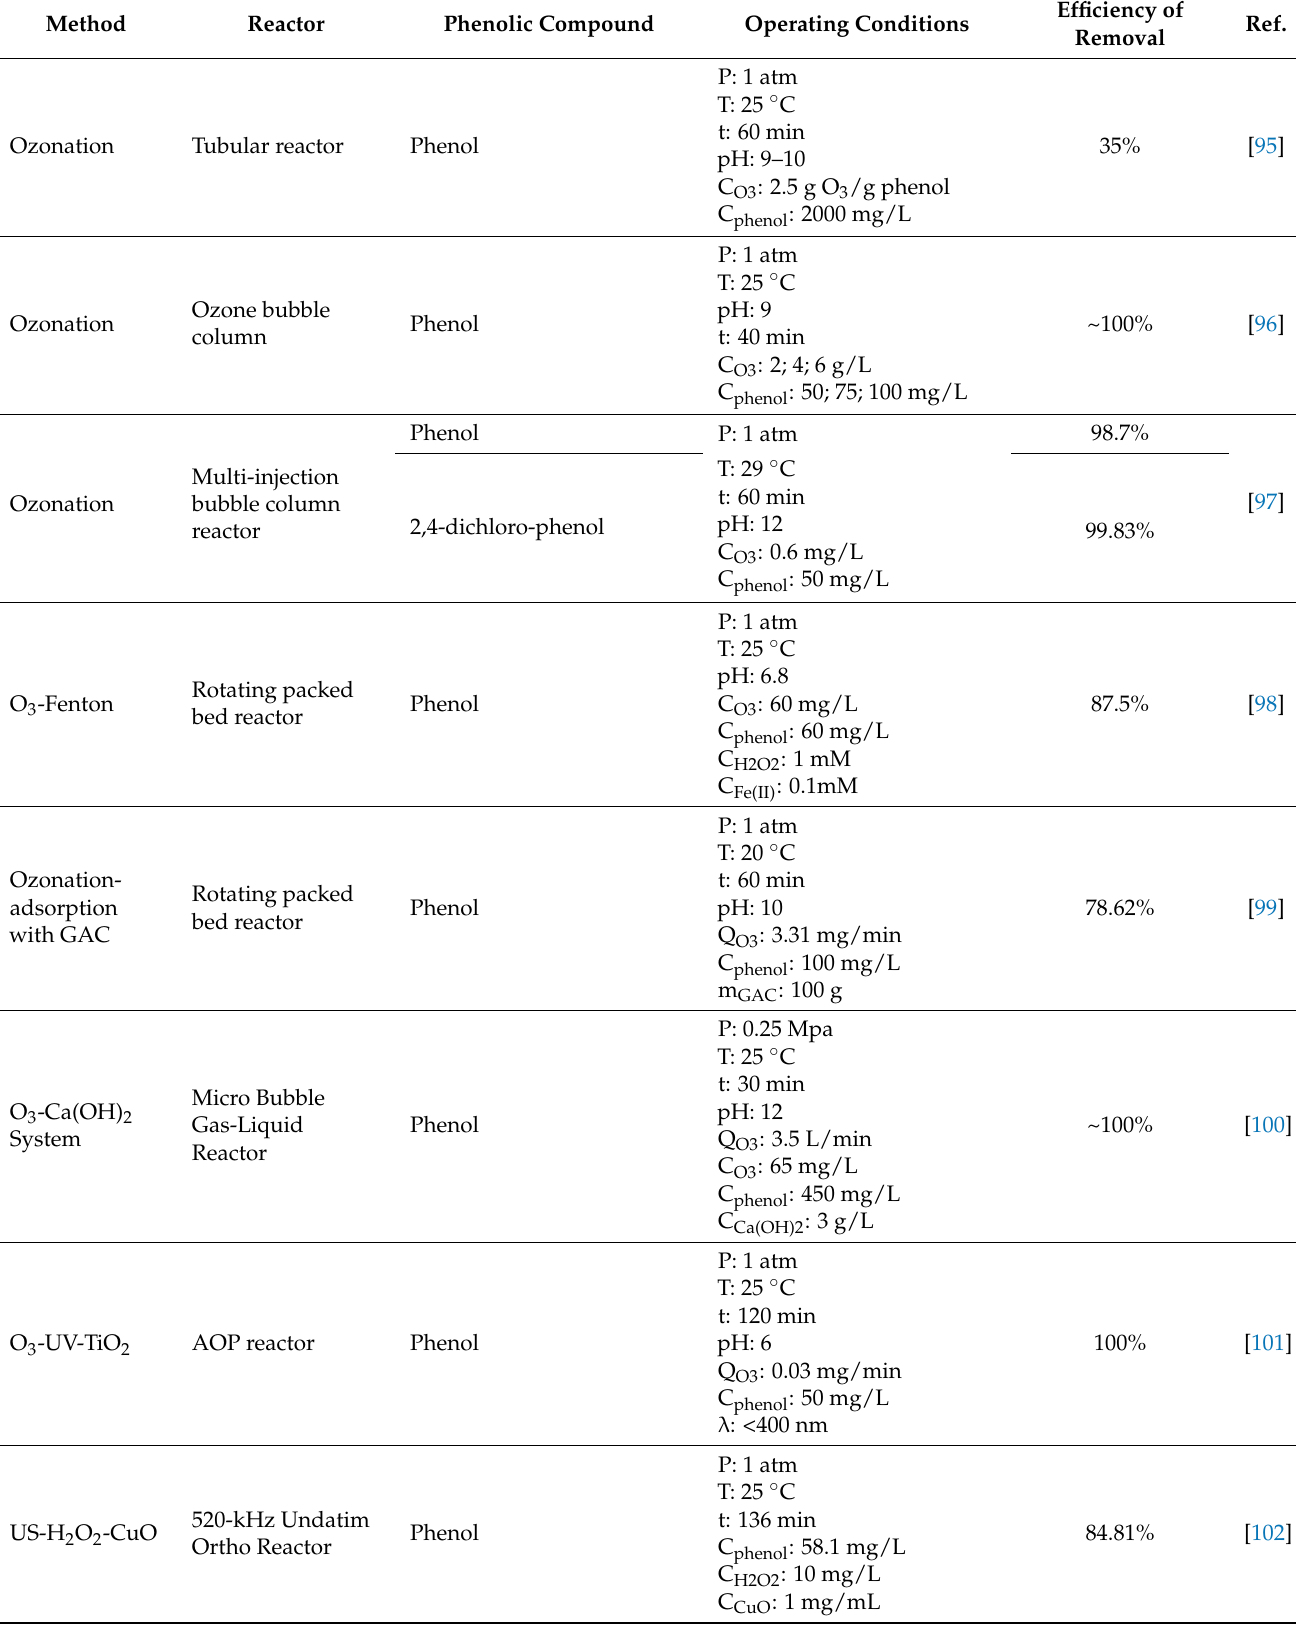
Table 11. Comparison of the efficiency for phenolic compounds removal using ozonation and AOPs ozone-based technologies.